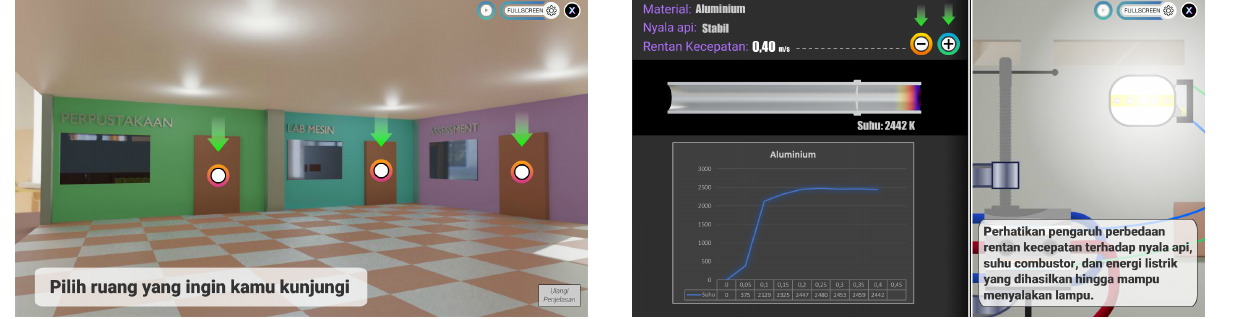
Figure 4: Rooms in a virtual laboratory